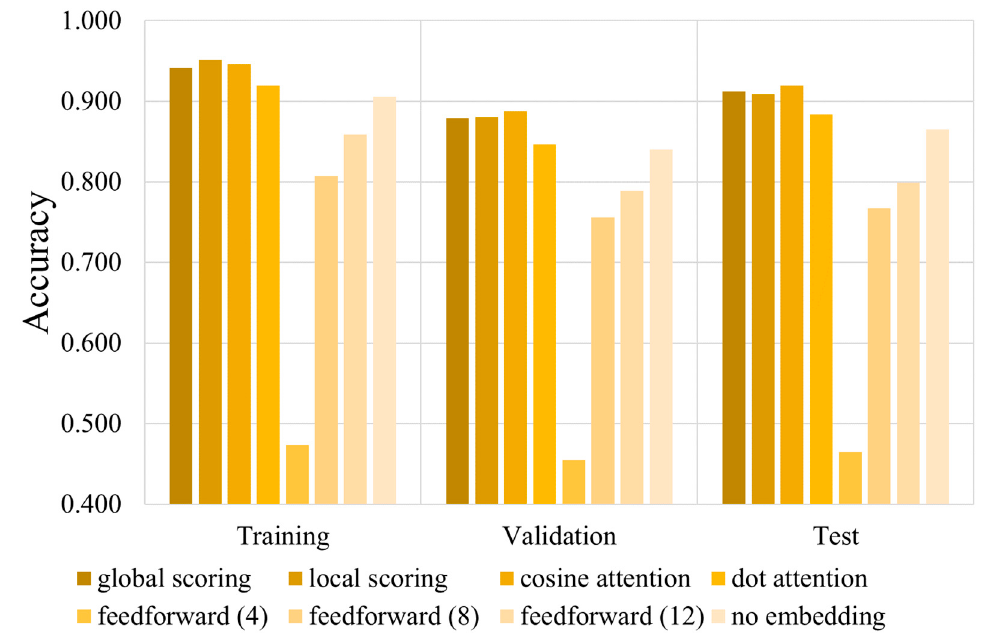
Appl. Sci. 2020 , 10 , x FOR PEER REVIEW Figure 22. Classification accuracies for different embedding functions. Figure 22. Classification accuracies for di ff erent embedding functions.